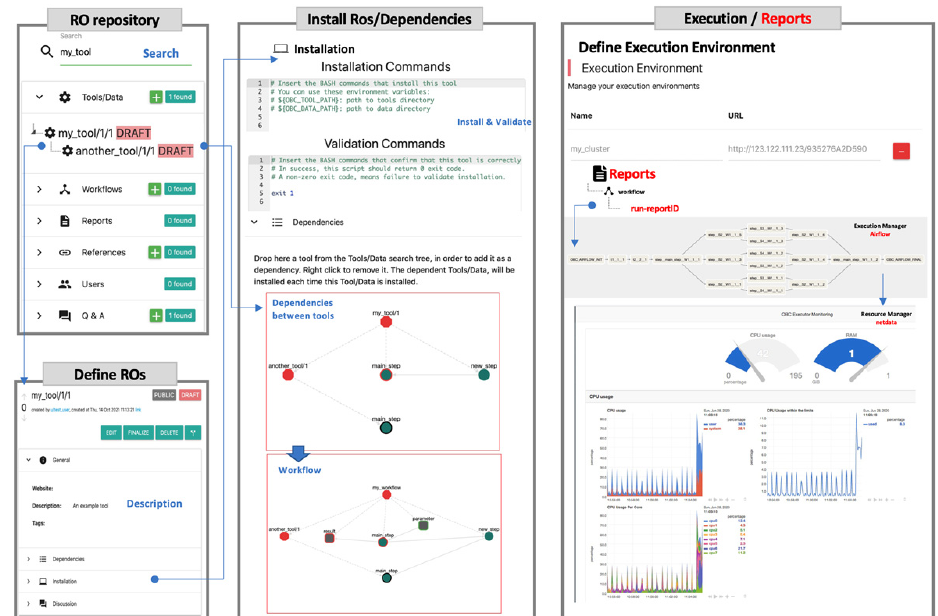
Figure 3. The four basic building blocks of the OpenBio.eu platform.